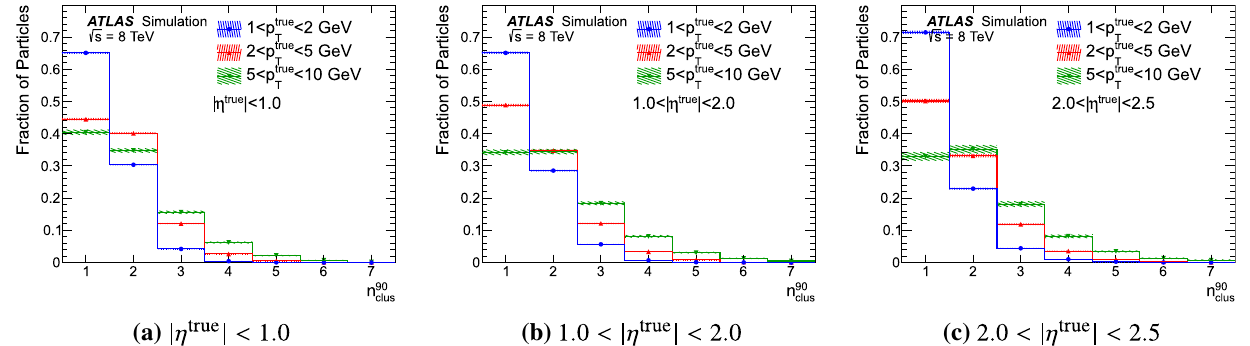
| η true | regions. The data are taken from a dijet sample without pile-up < 500GeV and the statistical uncertainties on the with 20 < p lead T number of MC simulated events are shown as a hatched band bins in three T T ,